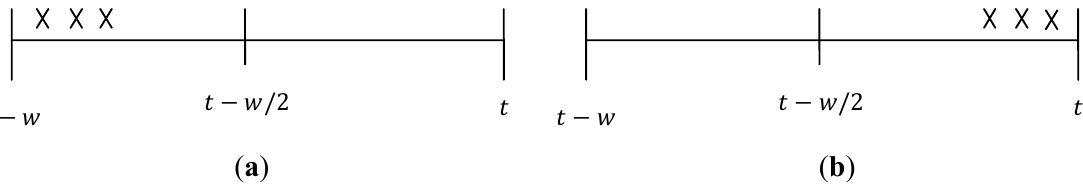
Figure 3. Illustration of mobile tag window sub-range as tags enters and exits the detection range. ( a ) Tags exiting; ( b ) Tags